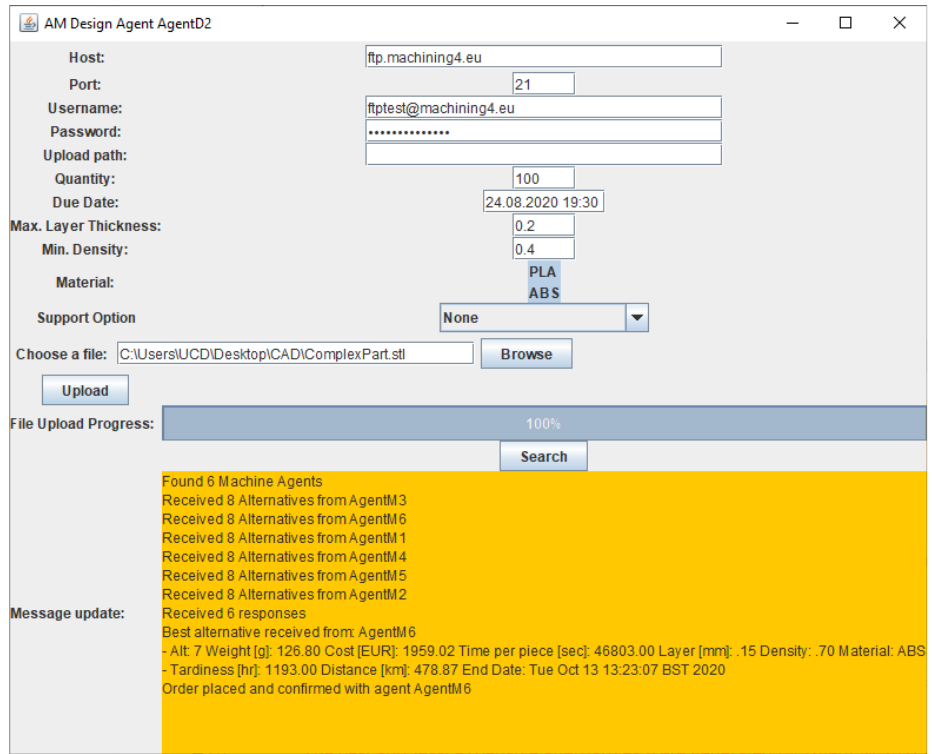
Figure 10. Test Case 2—Part geometry analysis tool integrated with a commercial CAD system.